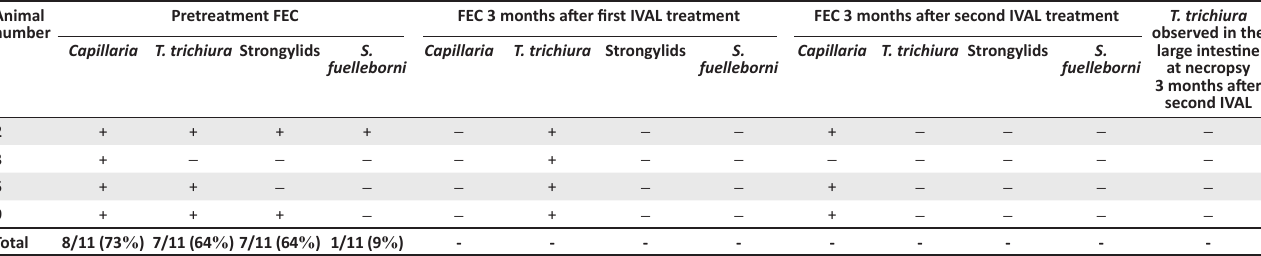
TABLE 3: Faecal egg count results and adult Trichuris trichiura found at necropsy in animals treated with ivermectin and albendazole. Animal Pretreatment number